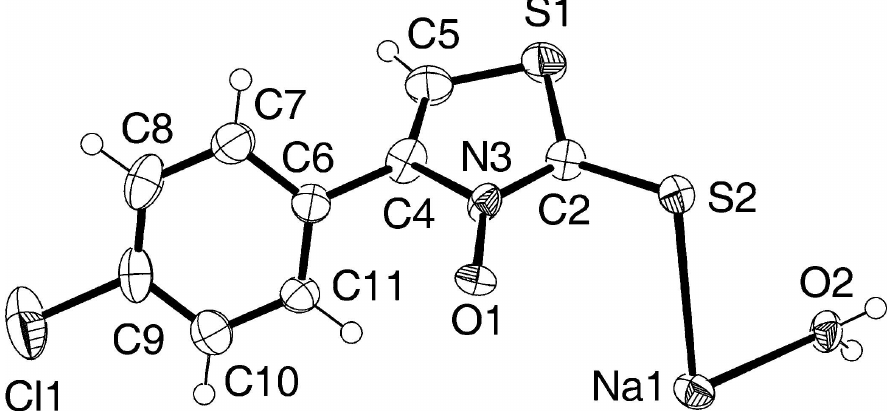
Molecular structure of (I). Displacement ellipsoids are plotted at the 50% probability